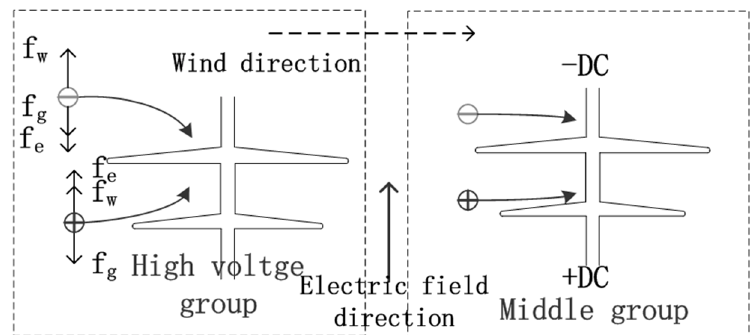
Figure 11. The trajectory trend of charged particles.